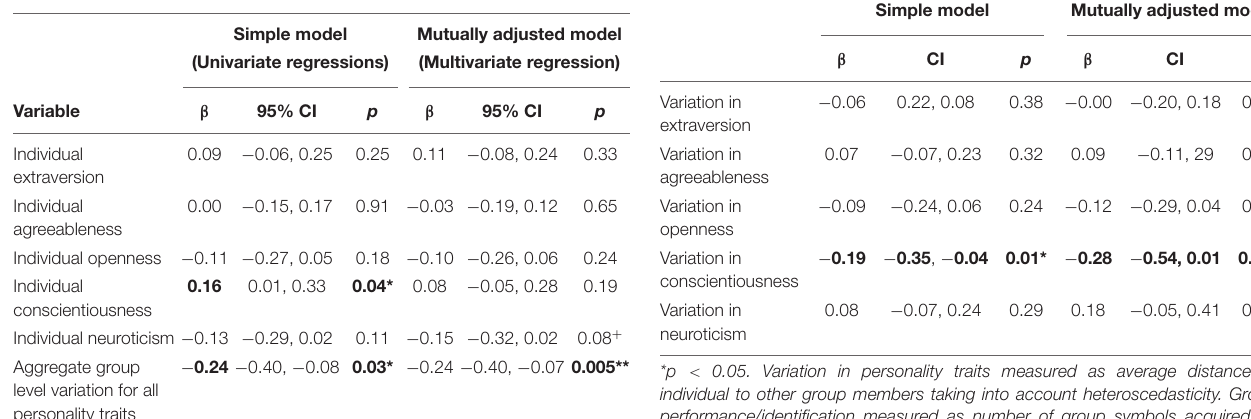
TABLE 2 | Group performance, personality traits, and combined variation in Big 5, N = 149; univariate and multivariate regressions.